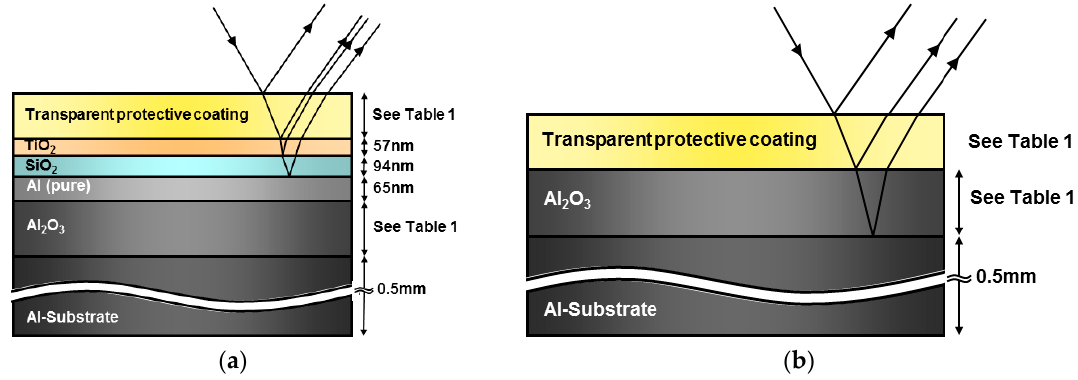
Figure 1. ( a ) Layer structure of materials A, B, C, D and ( b ) materials E, G, H, I.